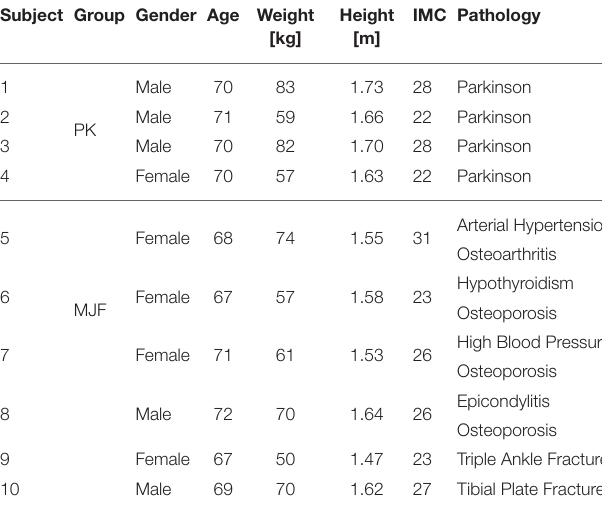
TABLE 1 | Summary of demographic data of the volunteers who participated in the clinical